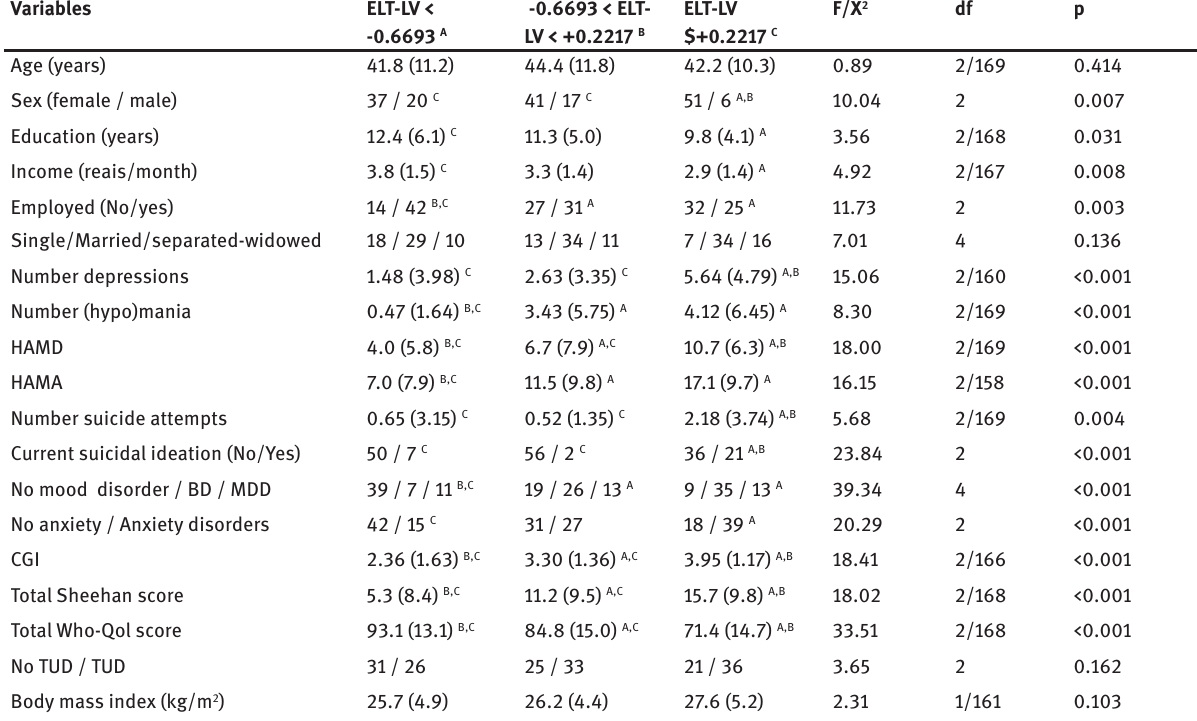
Table 2: Socio-demographic and clinical data of subjects divided into high, medium and low values of an early life trauma (ELT)-latent vector (LV).